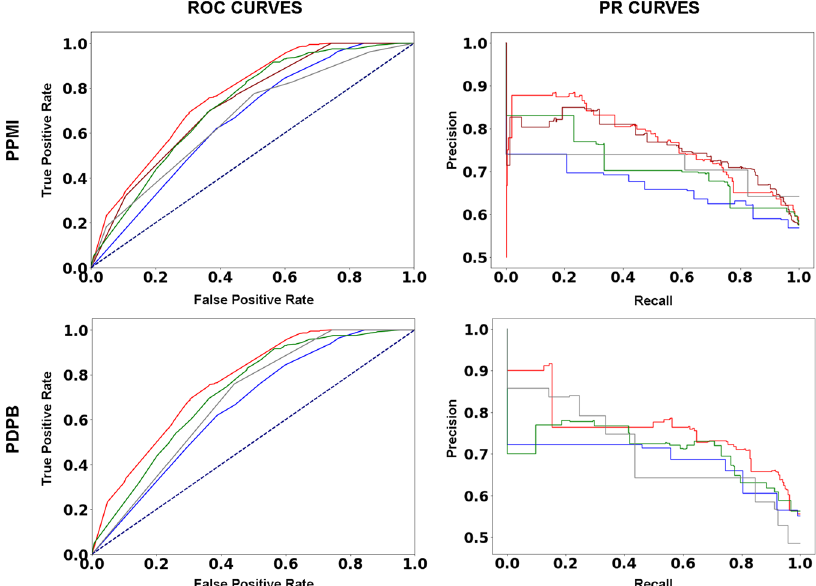
Fig. 4 12-month MDS-UPDRS Total meta-predictive performance and feature class contributions. Performance of 12-month MD-UPDRS Total progression meta-prediction as measured by area under (AUC) receiver operating characteristic (ROC; left) and Precision-Recall (PR; right) curves. PPMI train-test split (top) and independent testing on PDBP (bottom) are presented. Curves are presented for full models (red), without genetic features (blue), without physician examination (MDS-UPDRS III) (gray), without survey-based features (MoCA, MDS-UPDRS I and II) (green), and without imaging features (magenta, PPMI only). See Table 4 for ROC AUC and PR AUC